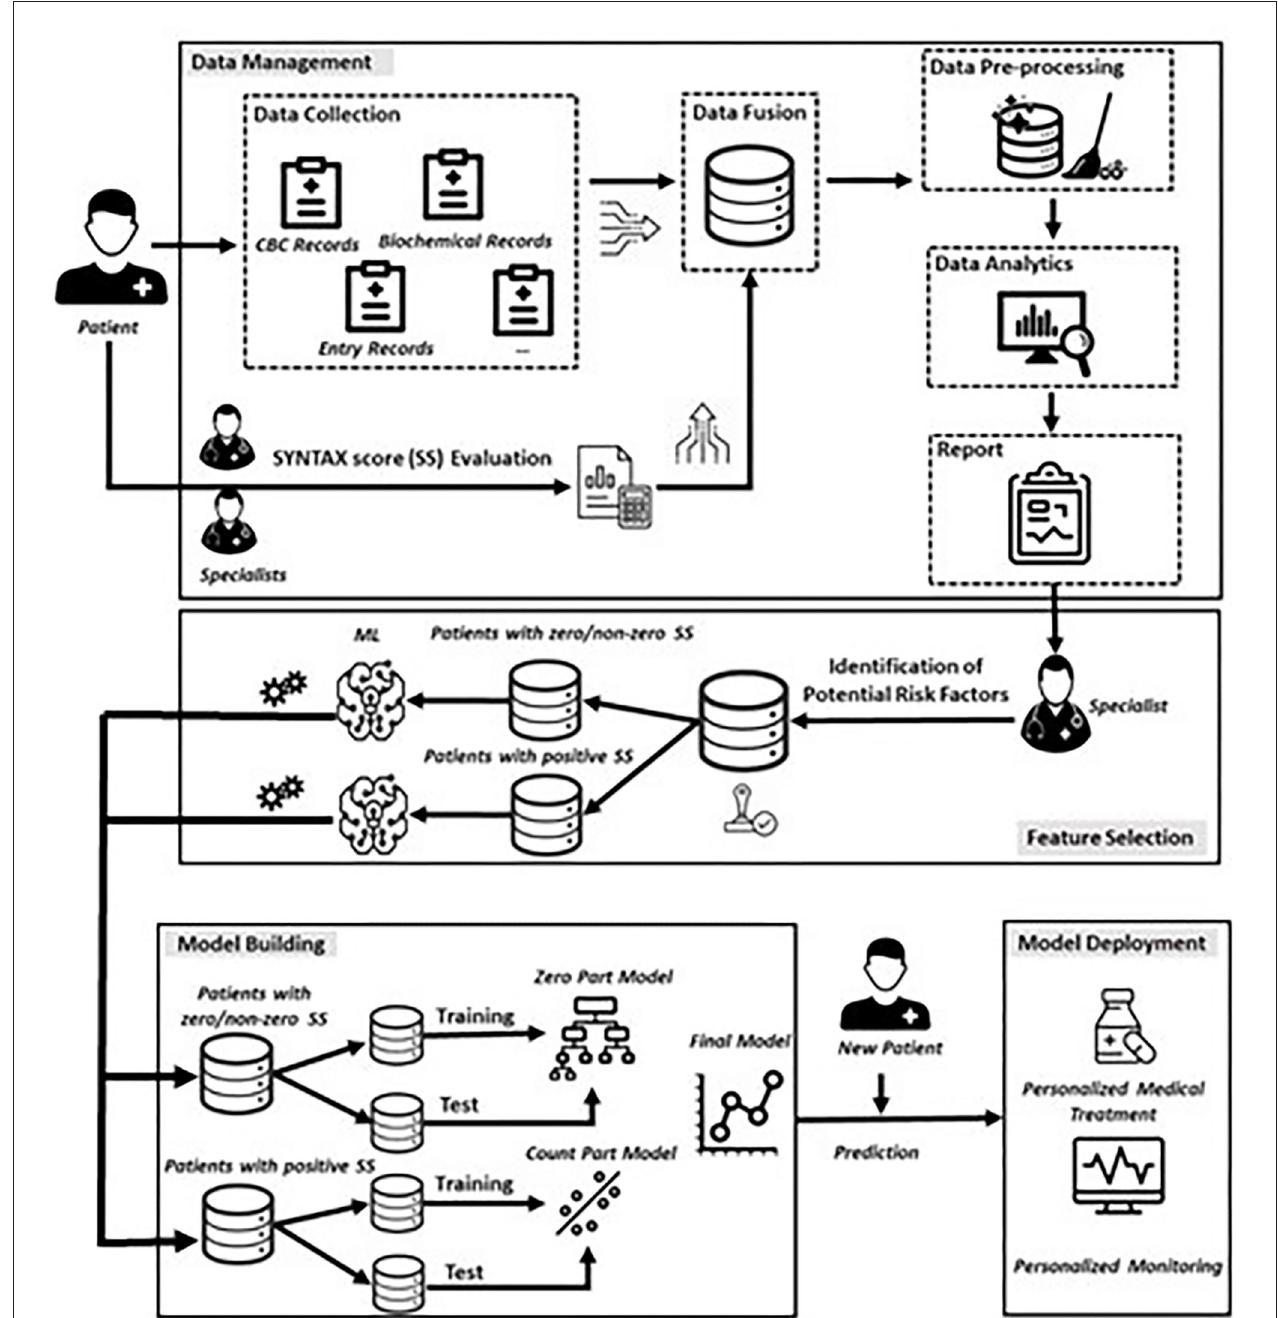
FIGURE 1 | Proposed data-driven